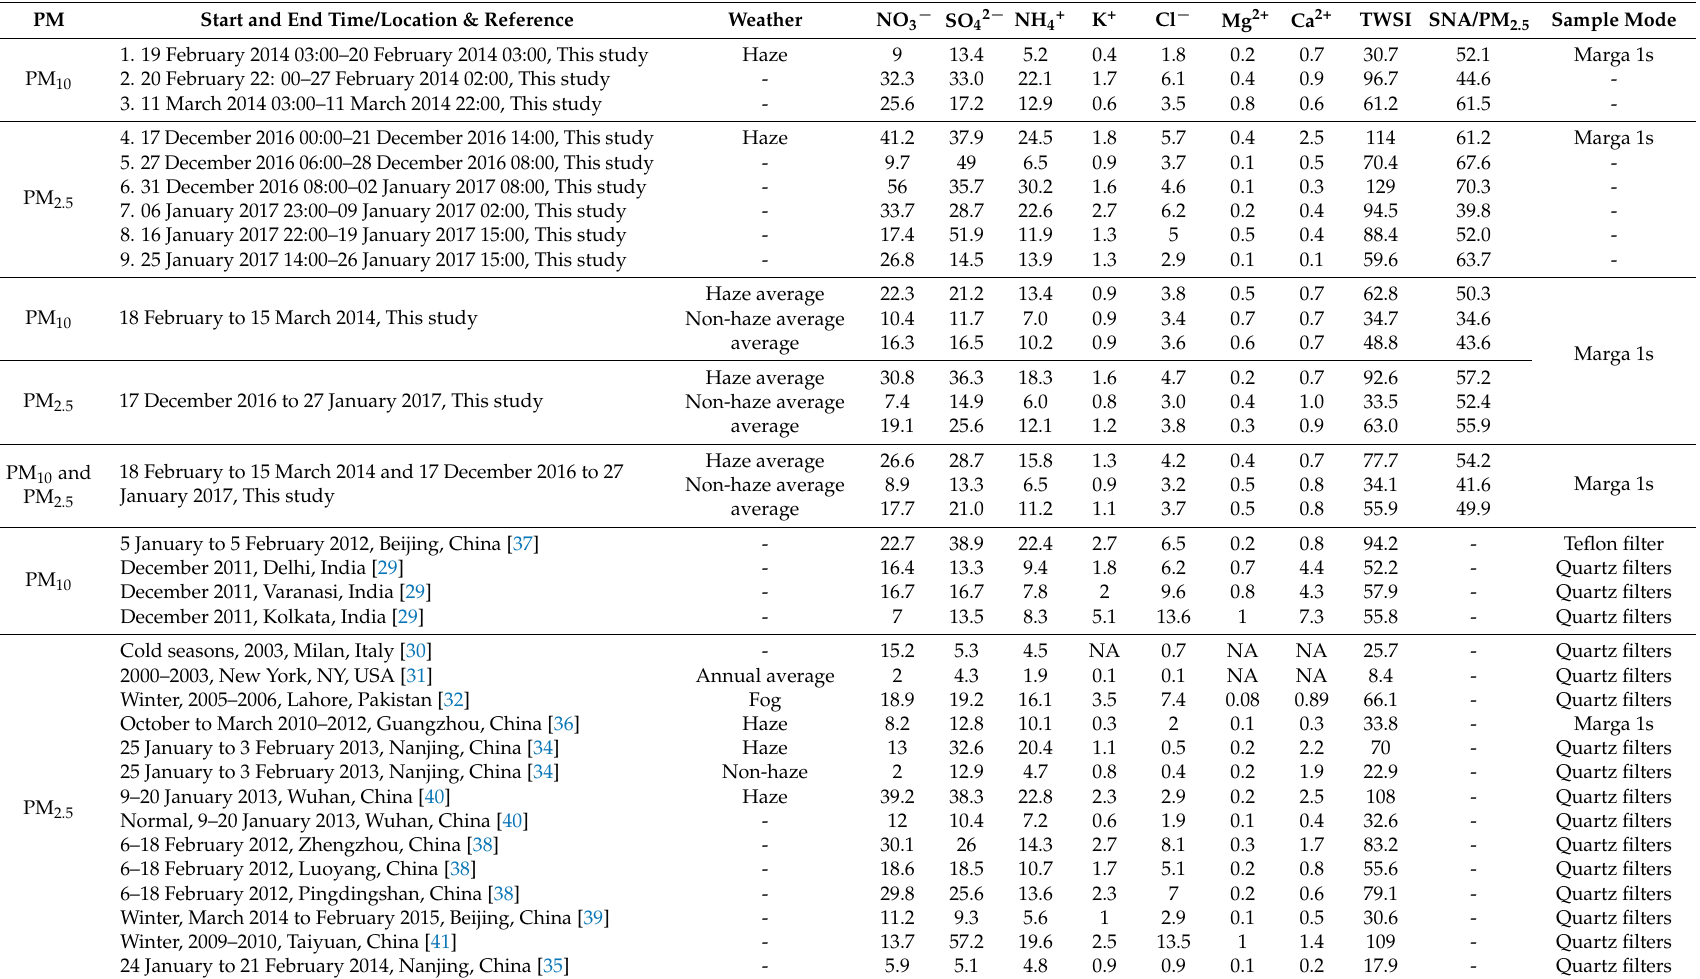
Table 1. Comparison of the average concentrations ( µ g · m − 3 ) of TWSIs ions among different cities on haze episodes and non-haze